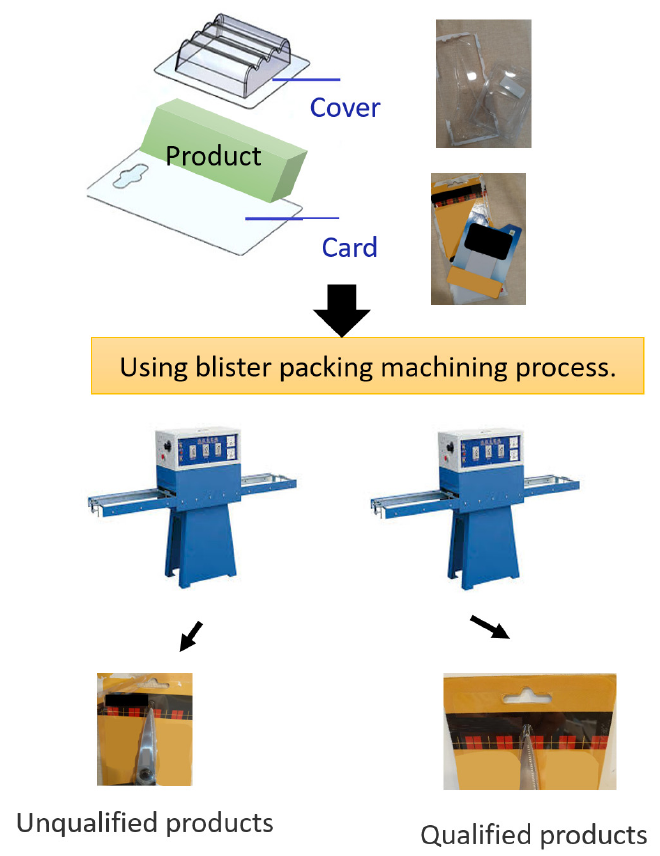
Figure 6. A case study in a practical manufacturing company.